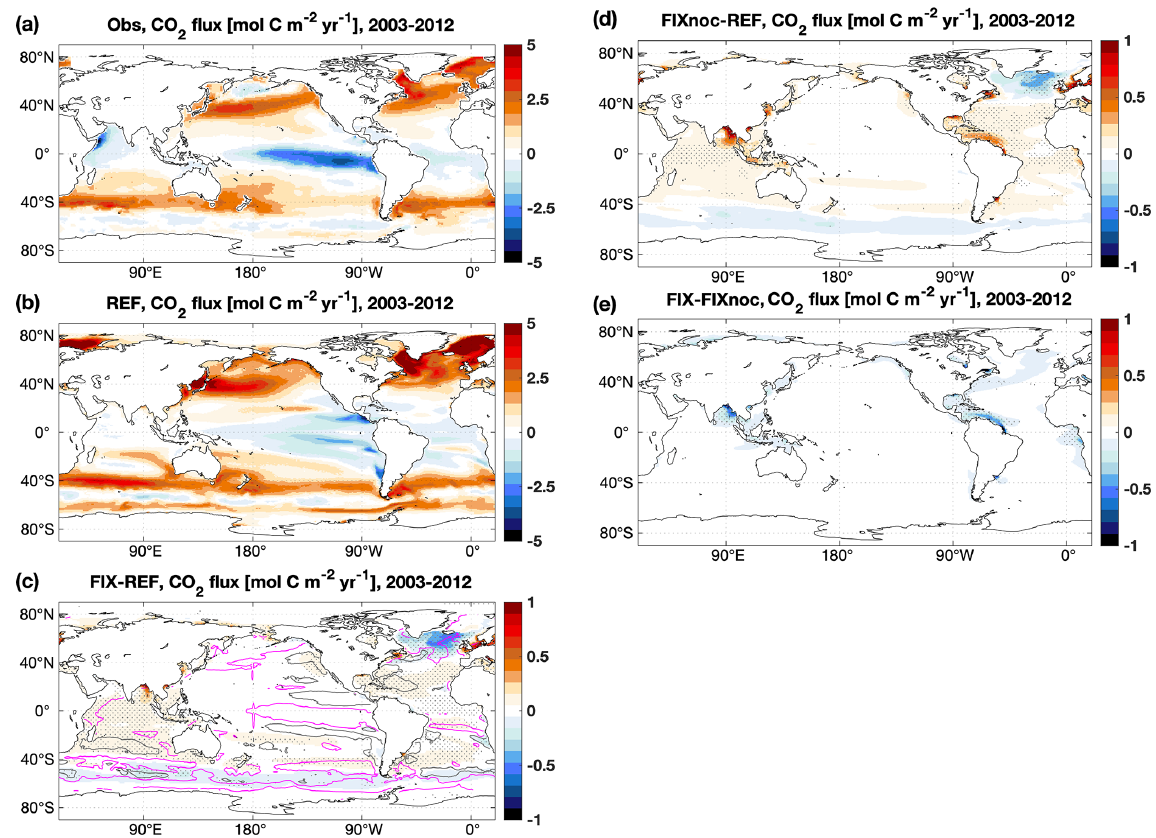
Figure 4. Annual mean air–sea CO 2 fluxes over the 2003–2012 period of (a) the observation-based estimates of Landschützer et al. (2017), (b) REF, (c) the difference between FIX and REF, (d) the difference between FIXnoc and REF, and (e) the difference between FIX and FIXnoc. Contour lines in (c) are the differences between REF and Obs, purple lines (0.6molCm − 2 yr − 1 ) indicate where REF overestimates C uptake compared to Obs, and grey lines ( − 0.6molCm − 2 yr − 1 ) indicate the opposite. In panels (c–e) , only significant differences are plotted, and dots denote areas where the signal is larger than the standard deviation of the absolute field (see details in Appendix B).